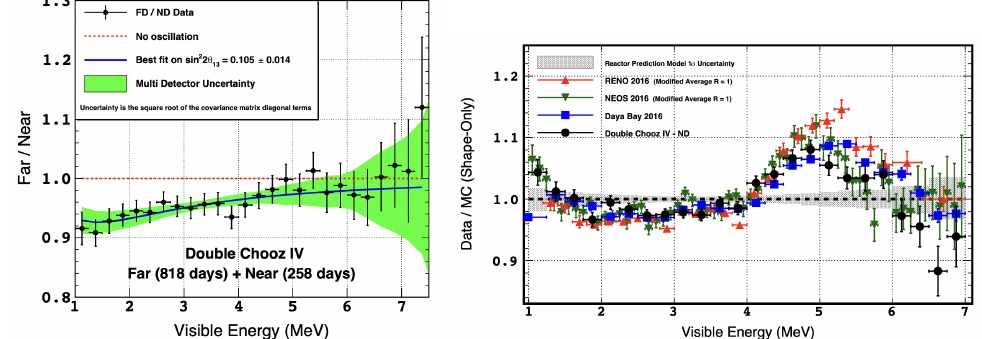
Figure 4. ( Left ): The FD to ND data ratio where the θ 13 disappearance pattern is observed. ( Right ): The data to prediction spectral ratio for the latest DC-ND [14] (black), Daya Bay [22] (blue), RENO [23] (red), NEOS [24] (green) are shown, exhibiting a common dominant pattern predominantly char- acterised by the 5 MeV excess. The reactor model prediction shape-only uncertainty is shown in grey